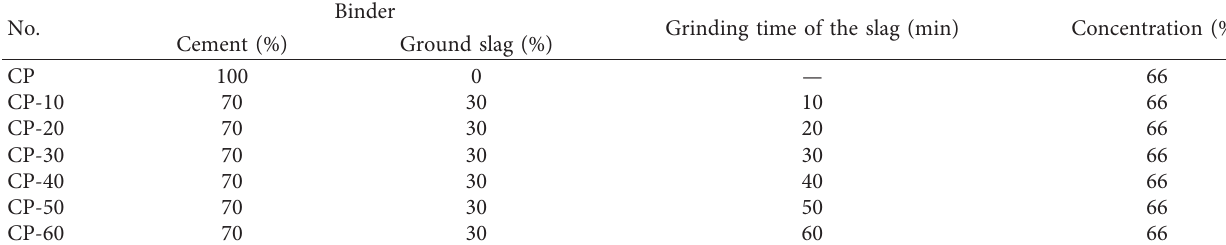
Table 5: The composition of the cemented paste samples.